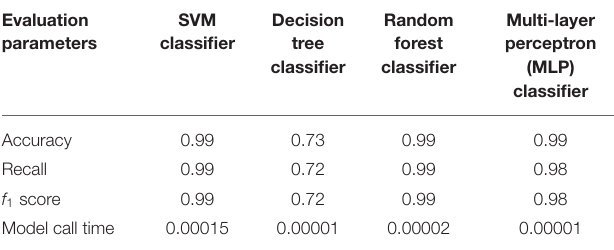
TABLE 2 | Recognition and evaluation results of the return motion of the tennis sports robot under different